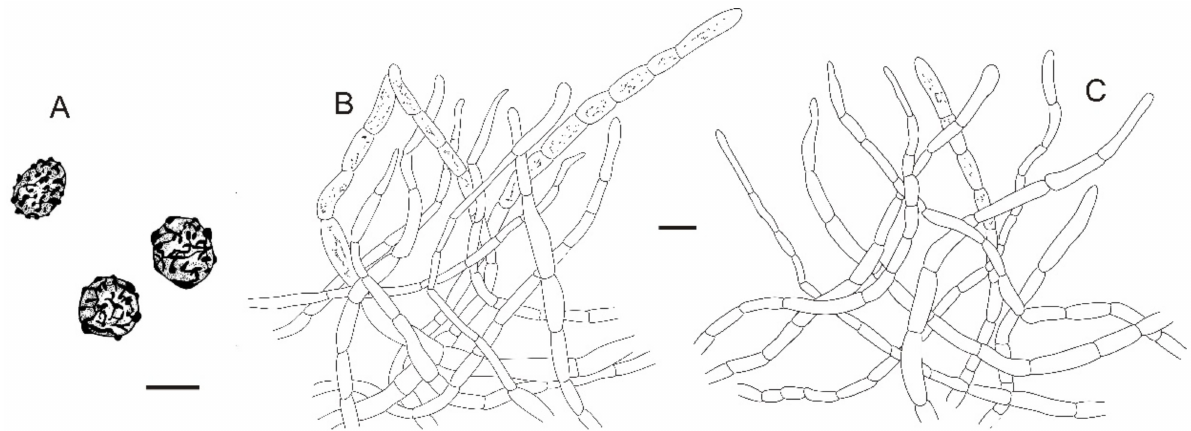
Figure 22. Microscopic features of Russula subversatilis (BJTC C653). ( A ) Basidiospores. ( B ) Hyphal terminations near the pileus margin. ( C ) Hyphal terminations near the pileus center. Scale bar: ( A ) = 5 µ m; ( B , C ) = 10 µ